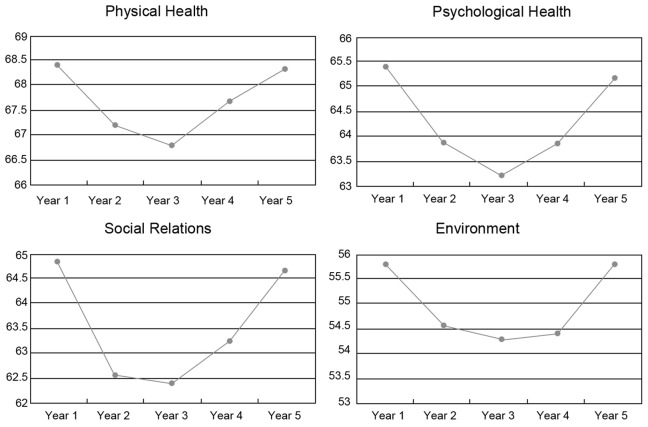
Scores of each domain for medical students.